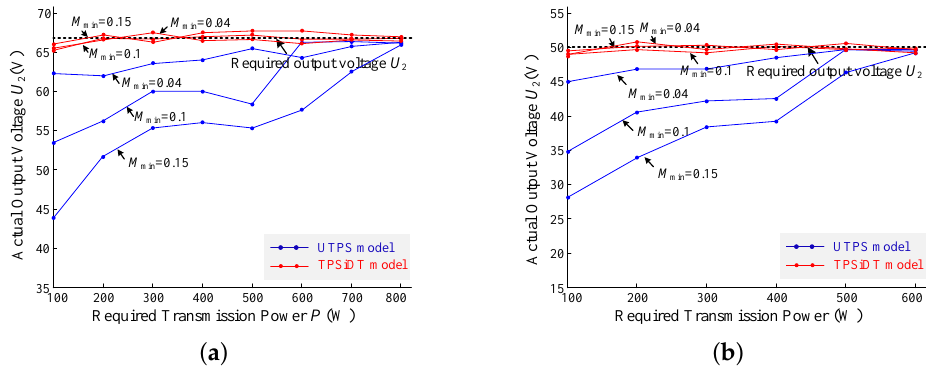
Figure 14. Comparative curves of the output voltage: ( a ) k = 1.5; and ( b ) k = 2.